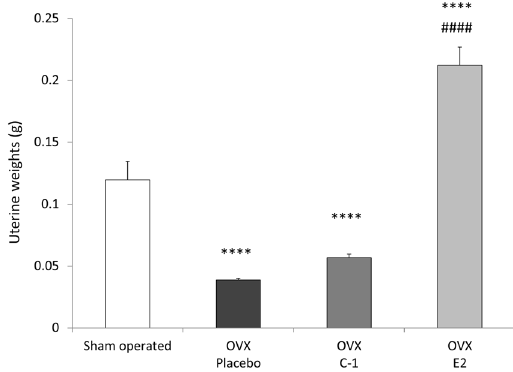
Figure 3. Uterine weights of sham-operated mice and ovariectomized mice administered placebo, C-1, or E2. Compared with placebo-administered mice, ovariectomized E2-administered mice but not C-1-administered mice, had higher uterine weight. Error bars represent standard errors of the mean. Post-hoc LSD test: **** P < 0.0001 as compared with sham-operated mice; #### P < 0.0001 as compared with placebo-administered